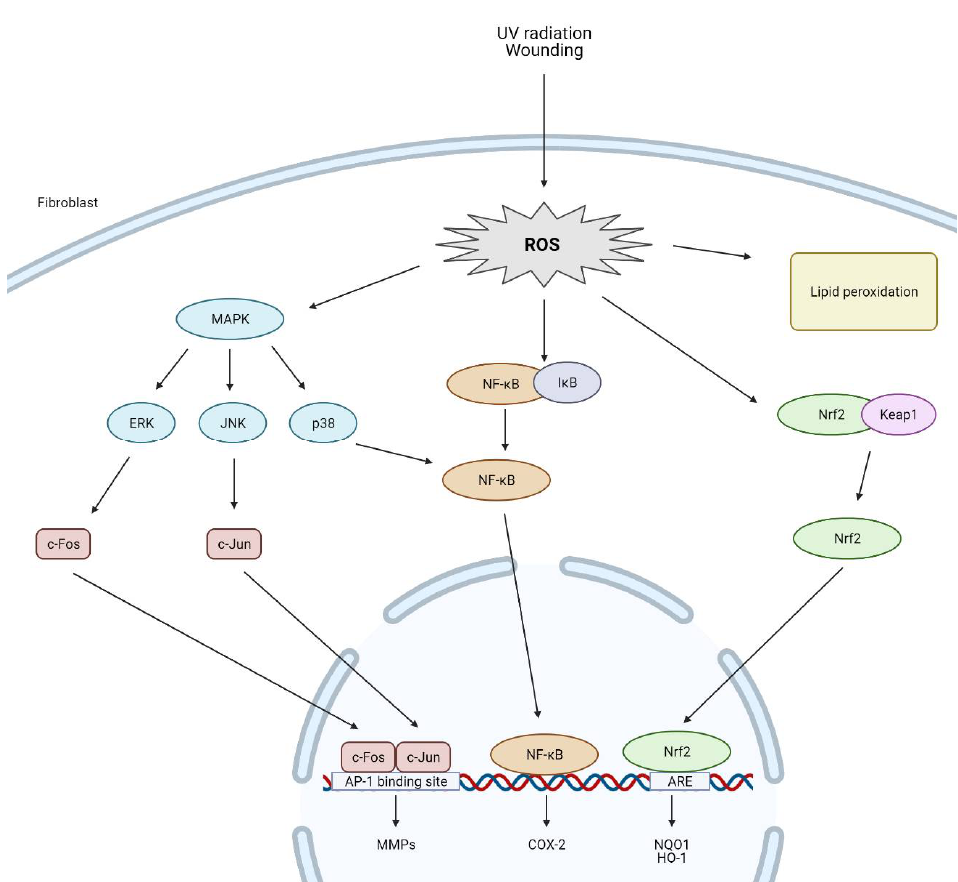
Figure 2. ROS-mediated activation of cell signaling pathways in dermal fibroblasts (created by BioRender.com).